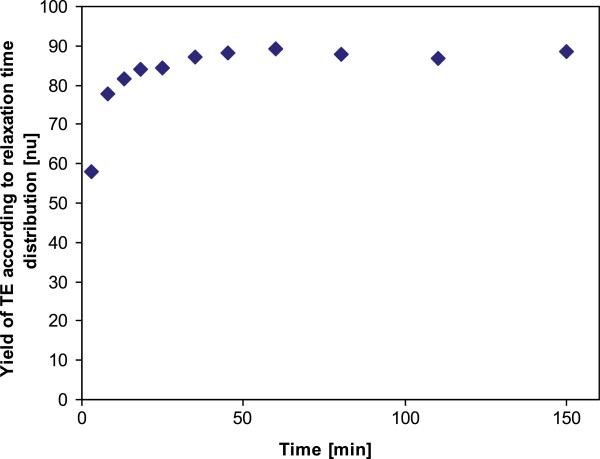
The kinetics of rapeseed oil TE as calculated using relaxation time distribution. Measurements were performed at-line using aliquots collected from the reaction flask. Samples were analyzed using PDCO.